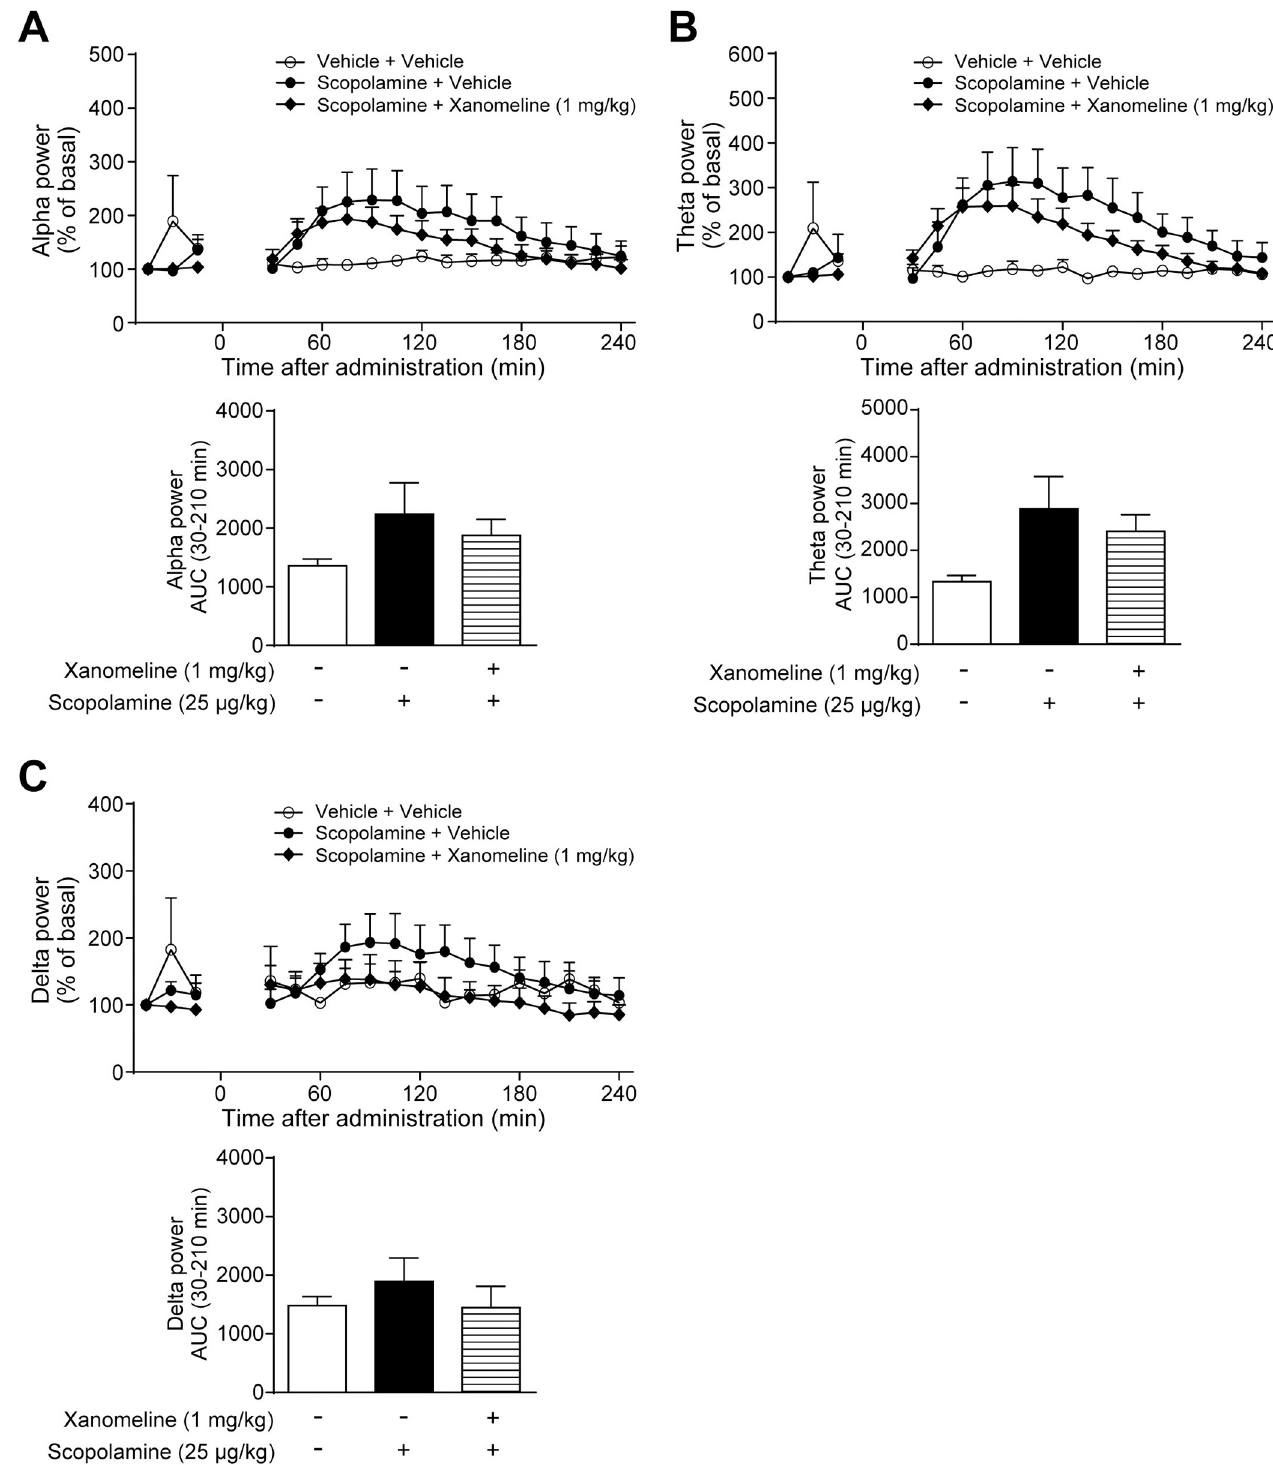
Fig 3. Xanomeline at 1 mg/kg tended to attenuate the scopolamine-induced qEEG changes. Scopolamine (25 μ g/kg, s.c.) and xanomeline (1 mg/kg, s.c.) were simultaneously administered to cynomolgus monkeys. After treatment with drugs or vehicle, (A) alpha, (B) theta, and (C) delta power bands of qEEG spectra were measured from 30 to 240 min. Results represent mean ± SEM of AUC between 30 and 210 min after treatment for 4 monkeys in each group. AUC, area under the curve; qEEG, quantitative electroencephalogram; SEM, standard error of the mean; s.c., subcutaneous administration.